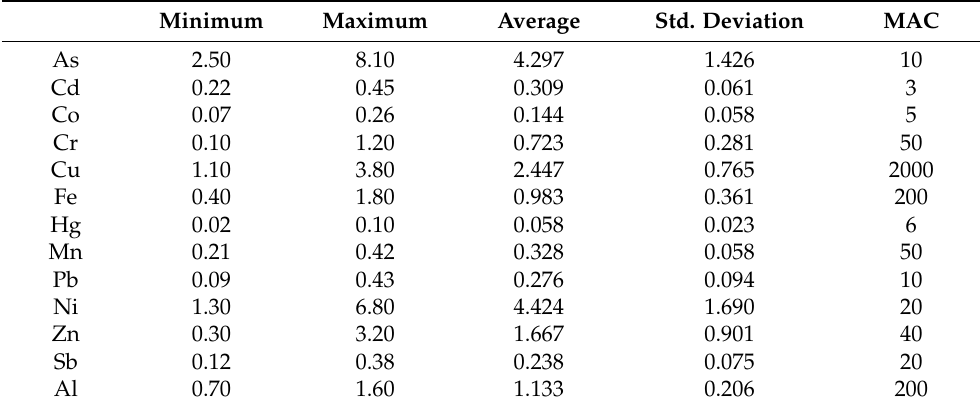
Table 1. Minimum, maximum, and average HMs values ( µ g/L) along with standard deviation and maximum admissible concentration (MAC) [43,44]. Minimum Maximum Average Std.